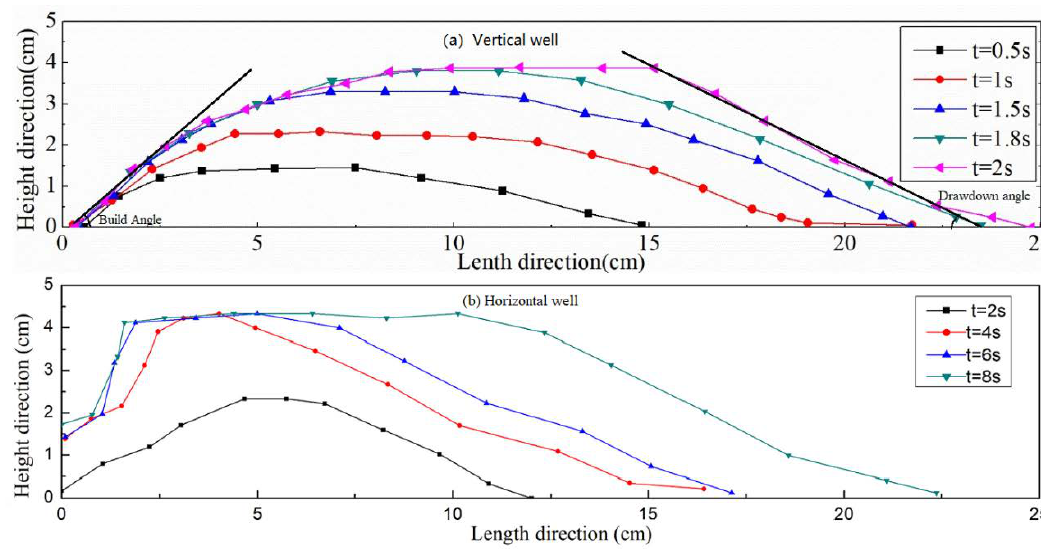
Figure 13. The growing process of proppant dune: ( a ) vertical well, ( b ) horizontal well.